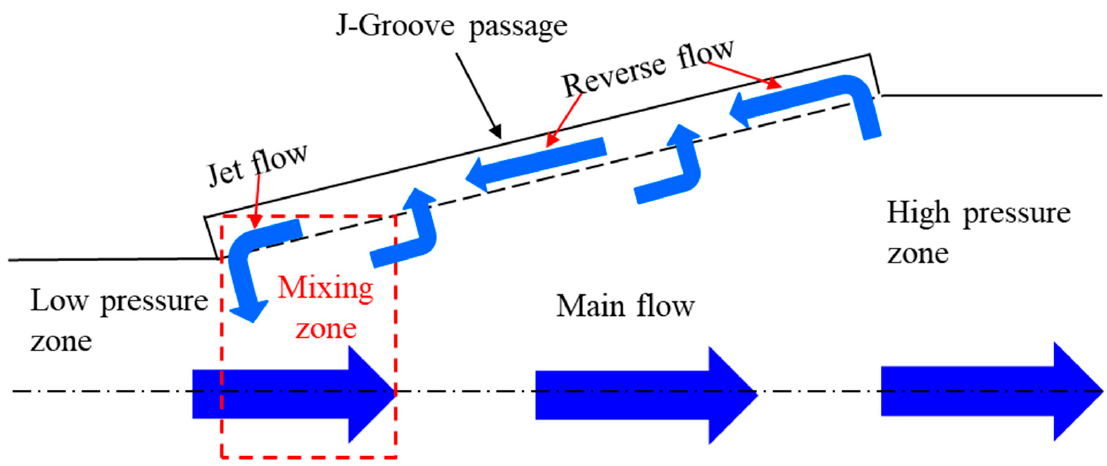
Figure 24. Relationship between suction performance and reverse flow rate ratio in the SCP model with J-Groove.